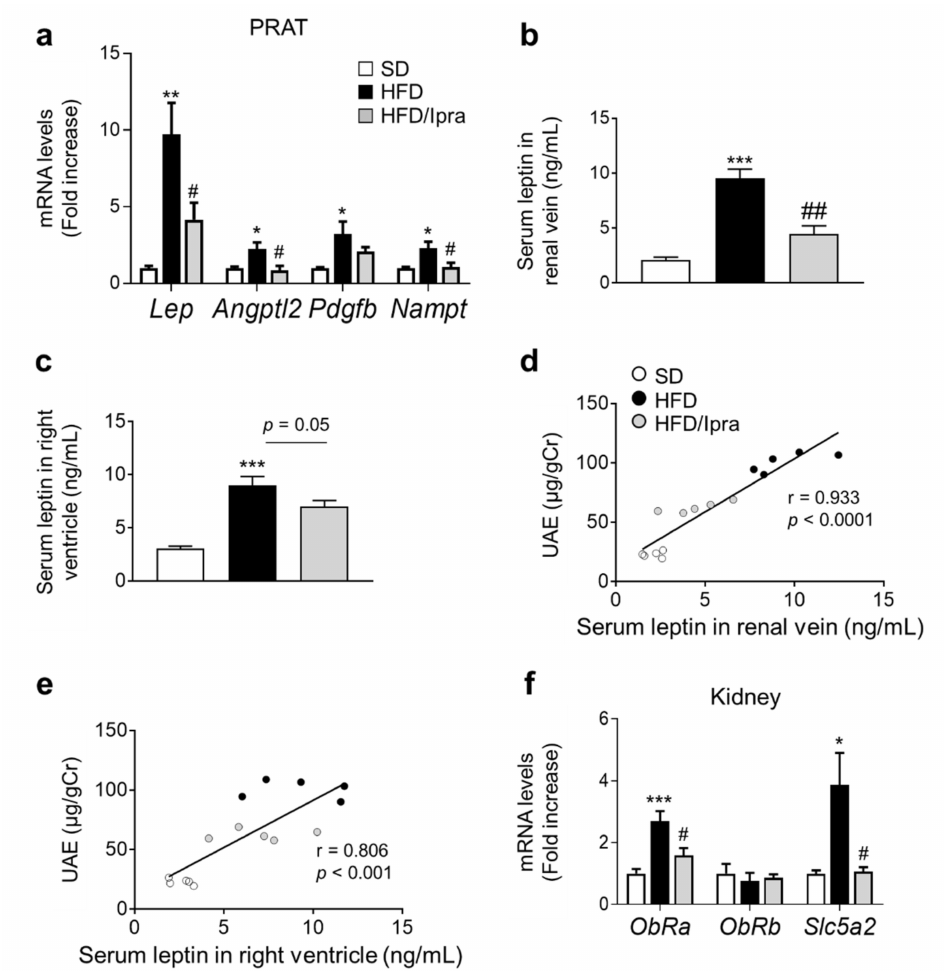
Figure 4. Leptin gene expression in PRAT and leptin levels in renal veins are reduced in Ipra-treated mice. ( a ) Expression levels of genes related to proliferative signaling in PRAT SD- or HFD-fed WT mice after 6 weeks of Ipra treatment. Serum leptin levels in ( b ) right ventricle and ( c ) right renal vein in SD- or HFD-fed WT mice during Ipra treatment for 6 weeks. ( d ) Correlation analysis between renal venous leptin concentration and urinary albumin excretion (UAE). ( e ) Correlation analysis between serum leptin concentration in right ventricle and UAE. ( f ) Gene expression levels of ObRa , ObRb , and Slc5a2 . WT, wild-type; SD, standard diet; HFD, high-fat diet; Ipra, ipragliflozin; PRAT, perirenal adipose tissue. * p < 0.05, ** p < 0.01, *** p < 0.001 vs. SD. # p < 0.05, ## p < 0.01 vs. HFD. n = 6 ( a , b , e ) n = 5 ( c